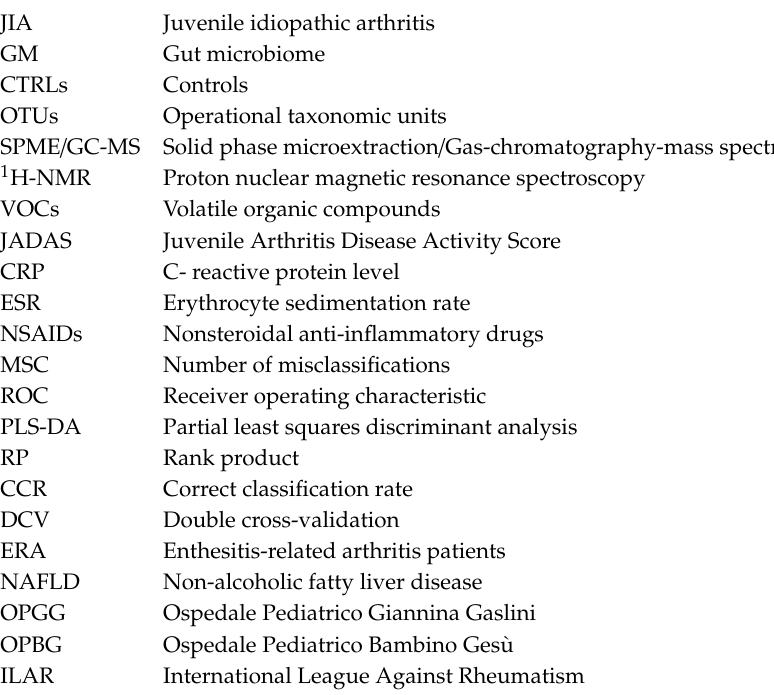
Table S1: Dietary habits, prebiotics and probiotics administration; Table S2: GC-SPME raw data; Table S3: NMR raw data; Text S1: Univariate